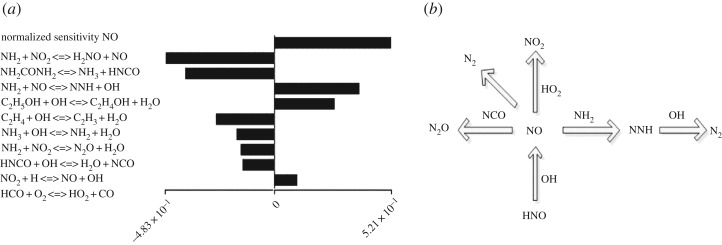
Sensitivity analysis and pathways of NO during urea-C2H5OH SNCR process.